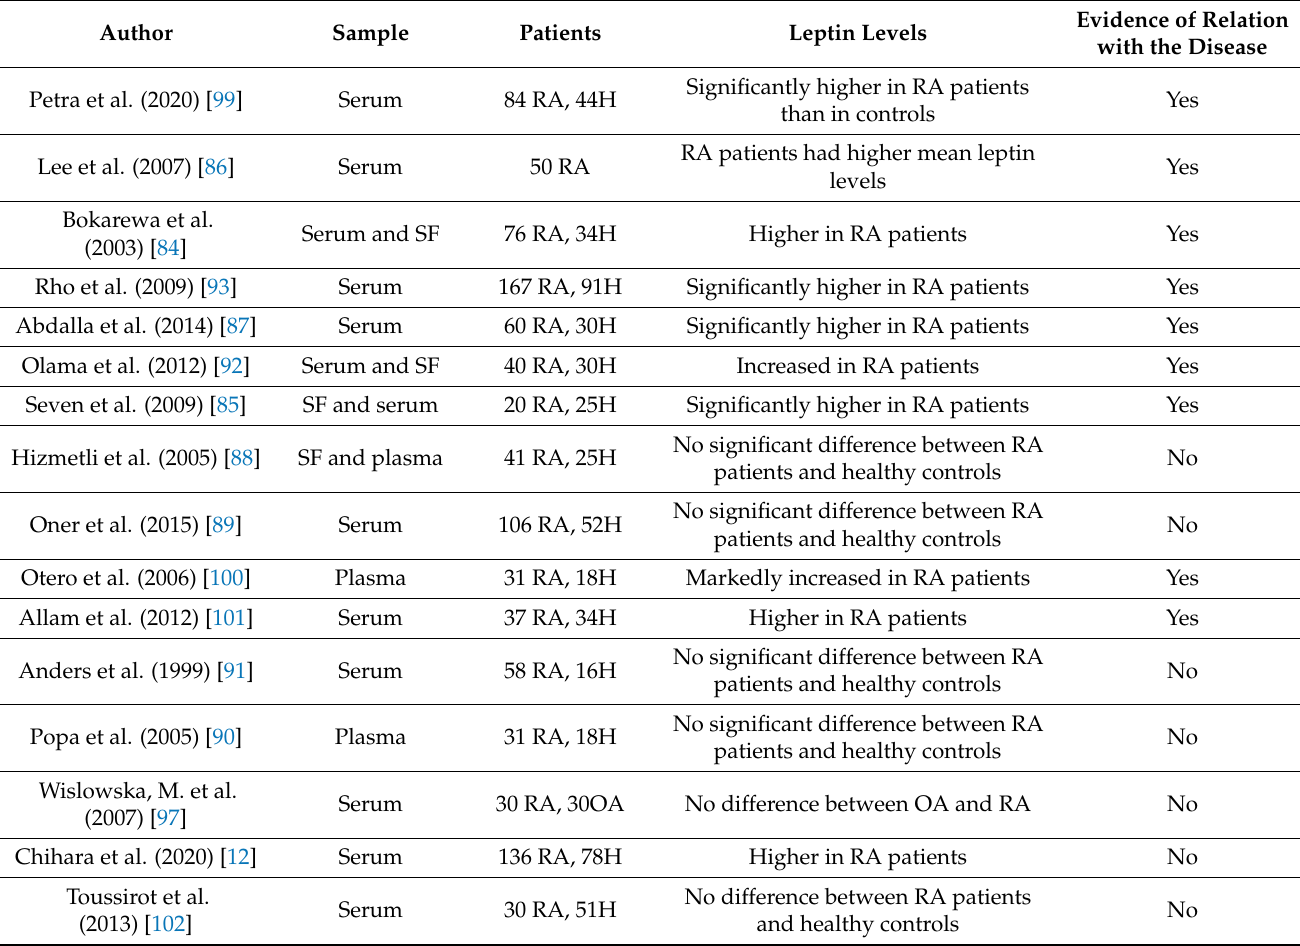
Table 2. Summary of clinical studies on leptin levels in serum and SF of RA